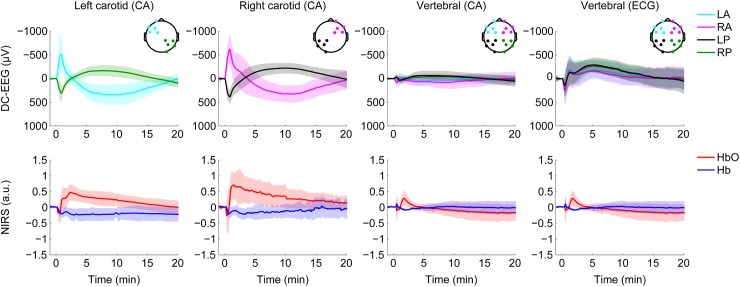
Grand average DC-EEG and average NIRS traces illustrating characteristic responses evoked by intra-arterial mannitol infusion.Each DC-EEG trace (upper panels; shaded area indicates values within ±1 SD) was generated by first calculating the mean of five electrode signals and then calculating the grand average of each recording. Mannitol infusion starts at time = 0 and lasts 30 s. DC-EEG responses upon carotid or vertebral artery mannitol infusion are shown using the common average montage (CA), however the responses to vertebral artery infusion are shown also after re-referencing to the distant ECG reference electrode (ECG; upper panel on the right). Bottom graphs show corresponding average oxy- and deoxyhemoglobin NIRS traces in arbitrary units (a.u.; ±1 SD). The number of NIRS recordings is less than that of DC-EEG, but all NIRS recordings are paralleled by simultaneously recorded DC-EEG data included in the upper graphs. Left (n = 13) and right (n = 16) carotid artery infusions induce a negative DC-EEG shift in electrodes above the treated arterial territory, which outlasts the infusion and is followed by a slower shift of opposite polarity. Contralateral posterior electrodes record a response that is qualitatively similar but reversed in polarity. A clear fall in the NIRS signals is seen during left (n = 8) and right (n = 8) carotid artery infusions, followed by a pronounced rise in HbO and a transient partial recovery of Hb after which Hb settles down on a level below the original baseline and HbO decreases slowly but does not fully recover. Vertebral artery infusions show a fronto-occipital DC-EEG potential shift (n = 18) without a lateralized effect, as expected. Re-referencing to the distant ECG reference electrode reveals that there is a negative shift throughout the entire scalp. The early transient shifts in the NIRS signals shown for vertebral artery infusions (n = 7) are more delayed and have much smaller amplitudes because NIRS was always measured on the forehead, i.e. they show responses generated in a non-infused brain area.